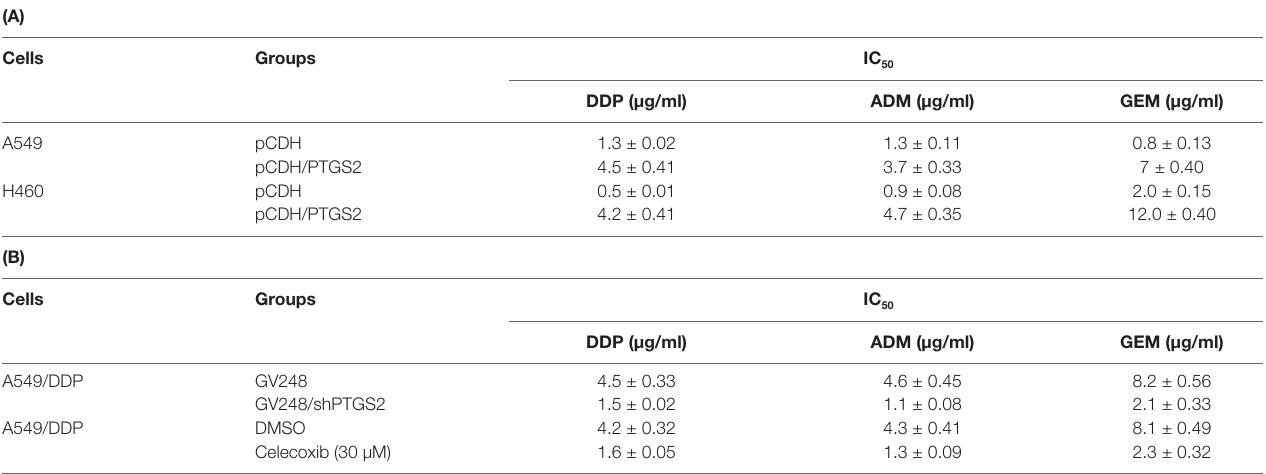
TABLE 1 | Prostaglandin-endoperoxide synthase-2 (PTGS2) promoted multidrug resistance in non-small cell lung cancer (NSCLC) cells.